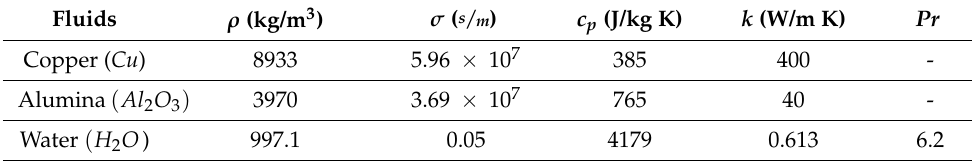
Table 2. Solid nanoparticles and base fluid(water) thermophysical